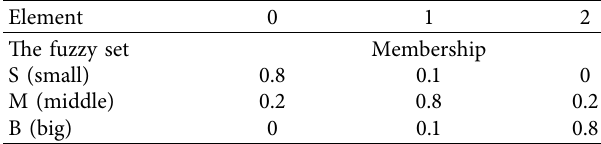
Table 2: Membership function of variable fuzzy set.